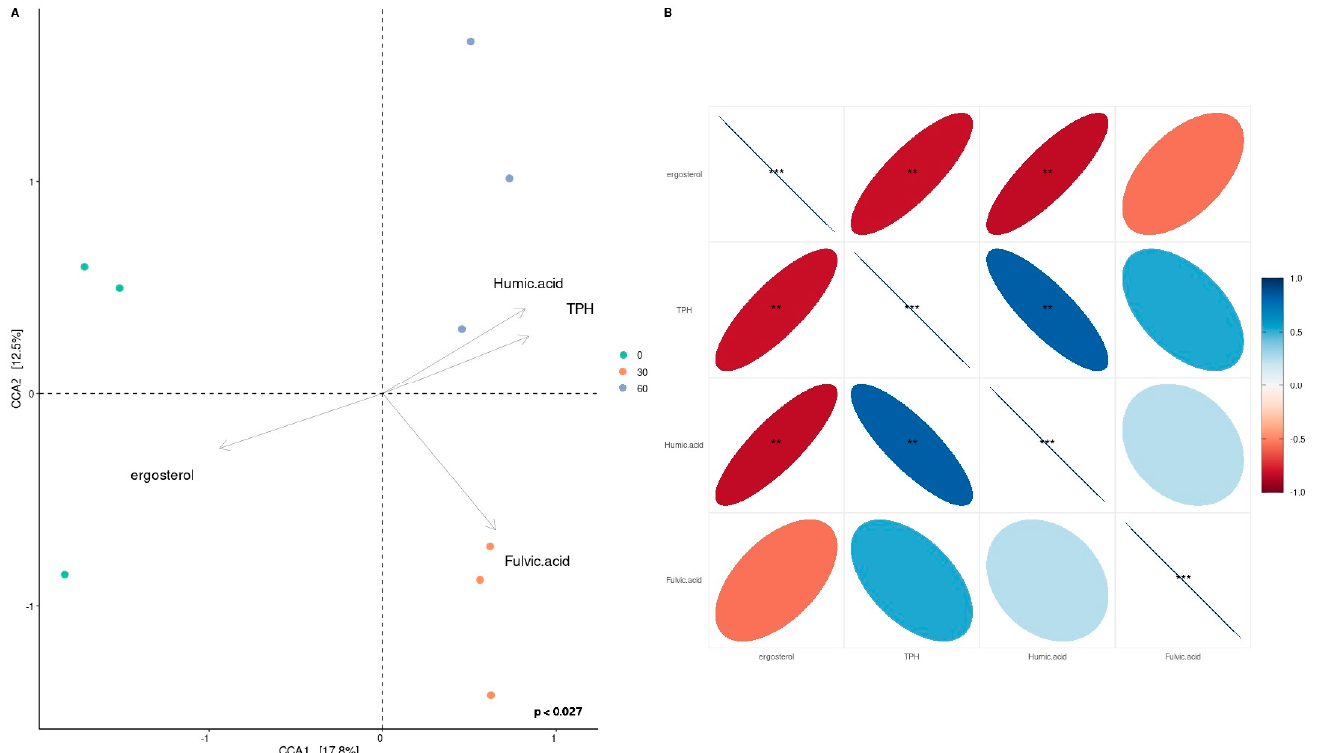
Figure 4. Canonical correspondence analysis (CCA) of SMS incubation. Canonical correspondence analysis (CCA) biplot ( A ) that shows correlation between ASV composition of each sample replicate and the environmental parameters: fulvic and humic acids, TPH, and ergosterol. Colours indicate time category for each datapoint. Black arrows are the eigen-vectors representing constraining variables. Reported p -value is calculated by PERMANOVA test performed on a full model with 999 permutations. ( B ): correlogram that reports correlation between environmental parameters, biomarker, and toxicological parameters. Heat colours and ellipse shapes represent degree of correlation, based on Pearson coefficient. Notation for p -value: ns for p > 0.05; ** for p ≤ 1 × 10 − 2 ; *** for p ≤ 1 × 10 − 3 , based on Fisher’s Z transformation of the aforementioned coefficients.